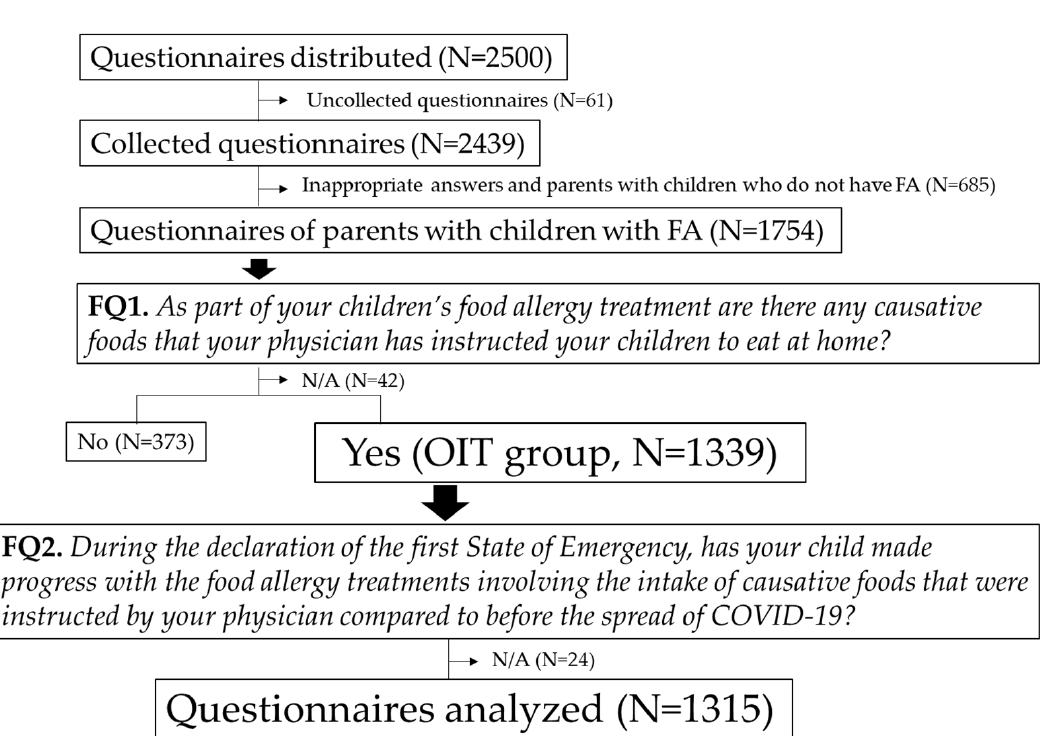
Figure 1. Flowchart of the participant selection process employed in this study.